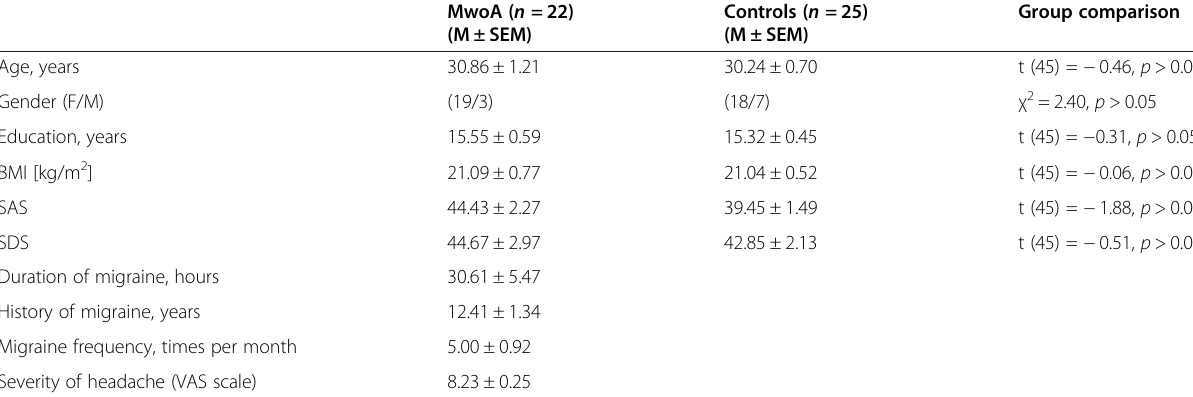
Table 1 Demographic and clinical characteristics of the study sample